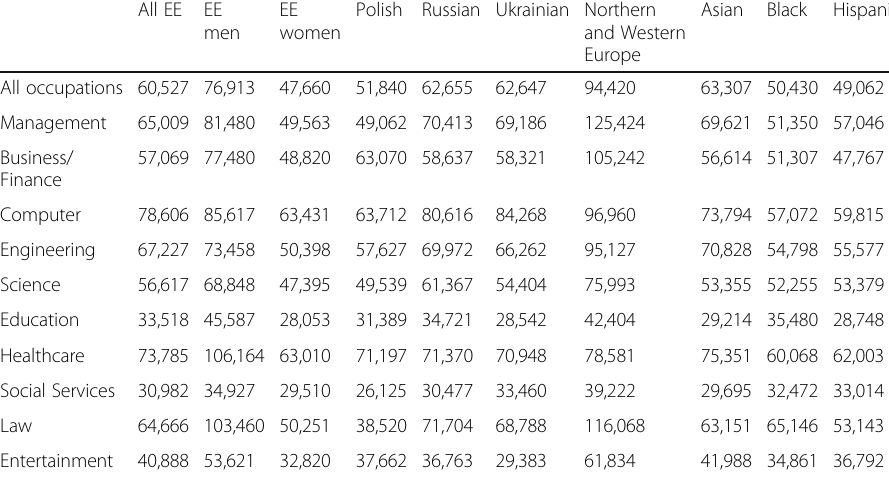
Table 7 Mean personal income of post-1991 immigrant professionals from Eastern Europe and various foreign-born groups, 2006 – 2009 ACS All EE EE